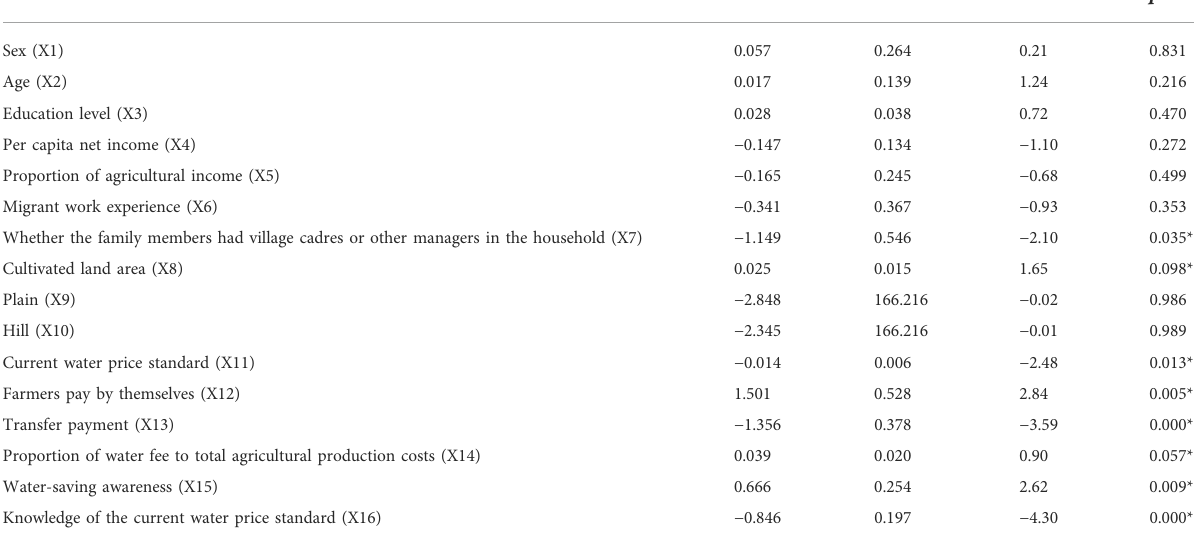
TABLE 5 In fl uencing factors for the willingness to